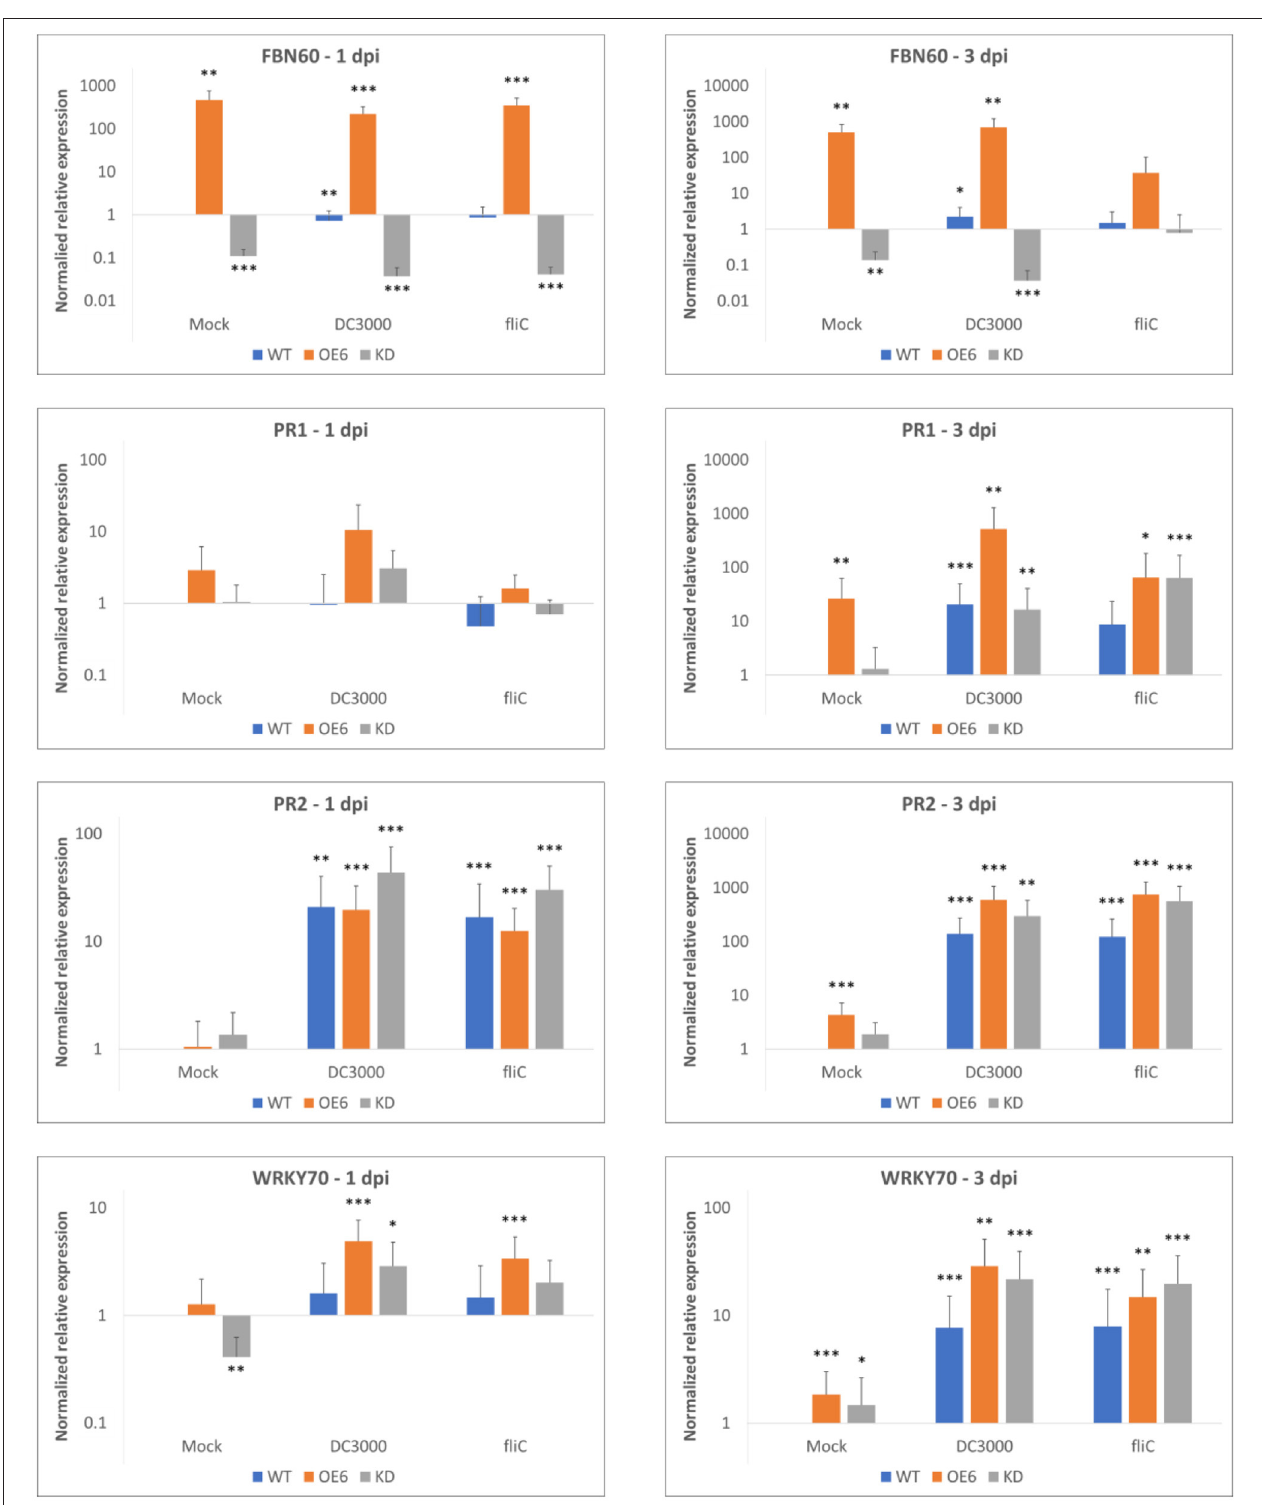
FIGURE 9 | Relative transcript levels for F-Box Nictaba (FBN60, At2g02360 ) and SA-defense pathway-related genes WRKY70 ( At3g56400 ), PR1 ( At2g14610 ), and PR2 ( At3g57260 ) in Arabidopsis thaliana plants after inoculation with Pst DC3000 or Pst DC3000 1 fliC mutant. Results were determined by qPCR analysis for three independent biological replicates. Error bars represent standard errors. Asterisks indicate the significance of statistical differences of the samples compared with wild-type mock-treated plants (* p < 0.05; ** p < 0.01; *** p < 0.001). Graphs are shown on a logarithmic scale.